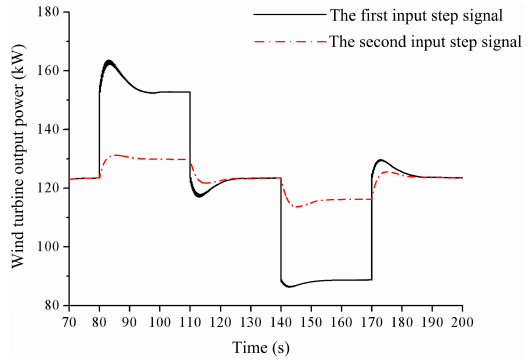
Figure 16. The wind wheel output power curve.